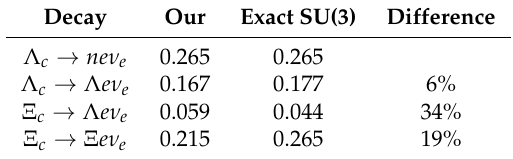
2 in ps 1 ( q = s , d ) V cq − | |